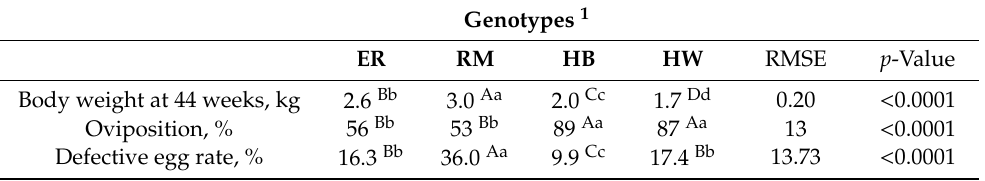
Table 1. E ff ect of genotype on yield performance of the hens from 29 until 44 weeks of age. Genotypes